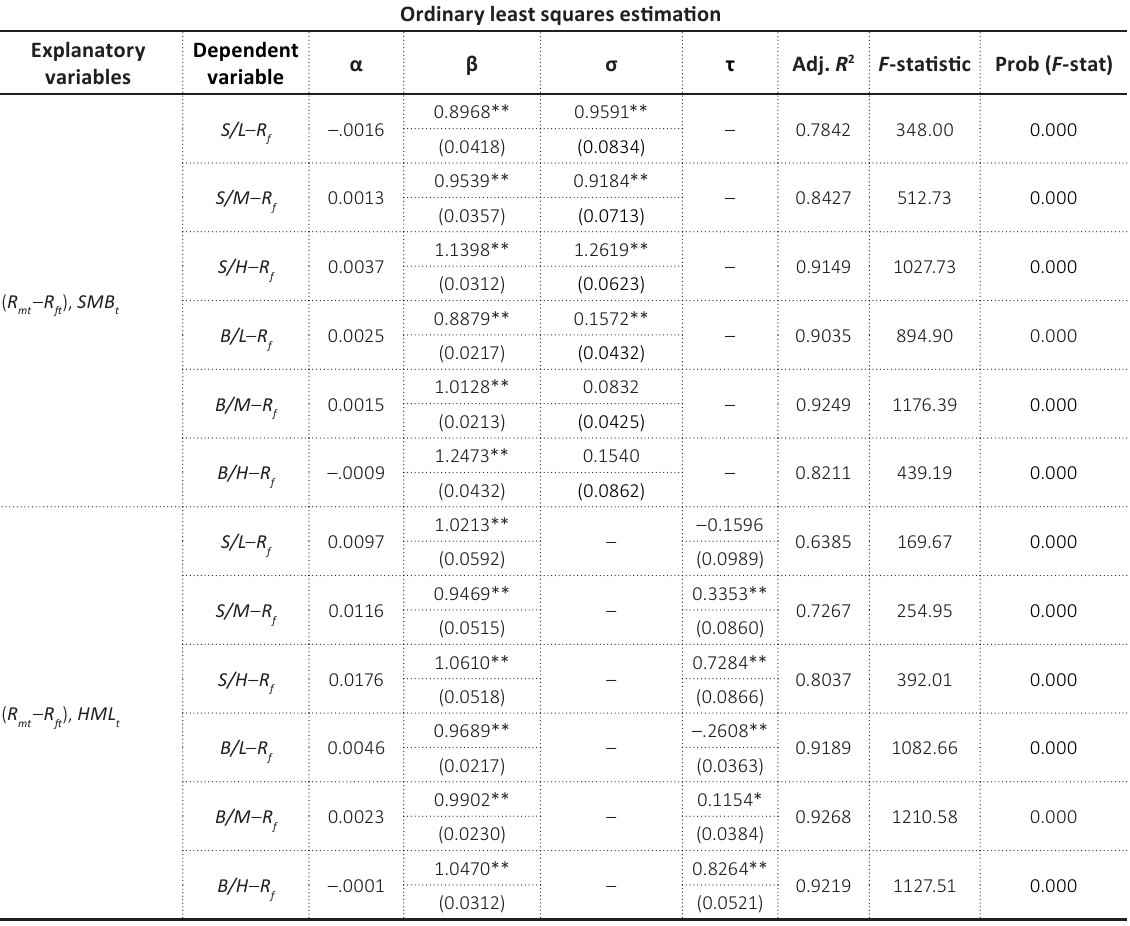
Table 2. Test results for Fama-French three-factor model in the Indian stock market Source: Calculated by the authors based on the data available on Prowess IQ database. Ordinary least squares